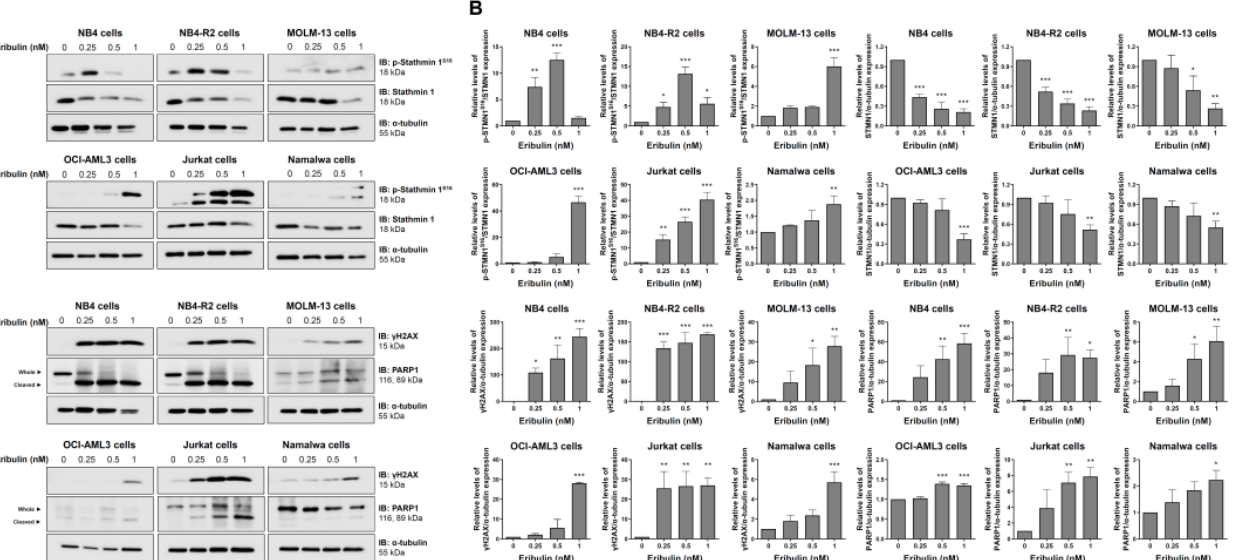
Figure 7. Resistance to eribulin is associated with the high expression/activation of MDR1, NFκB, and AKT in blood cancer cells. The heatmaps illustrate the expression of genes ( A ) or proteins ( B ) associated with resistance to eribulin in a panel of hematologic neoplasm cell lines. Gene data are represented as relative expression corrected by HPRT1 / ACTB expression. Downregulated and up- regulated genes are given by blue and red, respectively. Protein expression data are represented as relative levels corrected by the expression of GAPDH. Downregulated and upregulated proteins are indicated by yellow and purple, respectively. ( C ) Representative Western blot analysis for phos- pho(p)-AKT S473 , AKT, (p)- NFκB p65 S536 , and NFκB p65 in total cell extracts from myeloid and lym- phoid neoplasms cell lines. ( D ) Correlation graphs between expression of ABCB1 , ABCC1 , TUBB3 , STMN1 , p-AKT, AKT, p- NFκB, or NFκB and IC 50 values for eribulin in blood cancer cells. ( E ) Using molecular markers that significantly correlate with IC 50 to eribulin in hematologic neoplasms, a re- sistance eribulin-related targets (RERT) score was created, in which each cell line receives one point for each gene/protein upregulated (the median was used as the cutoff; the maximum number of points = 5). The radar graph shows the distribution of points among the analyzed cell lines. We note that the score precisely correlated with the drug ’ s sensitivity in the cellular models evaluated.